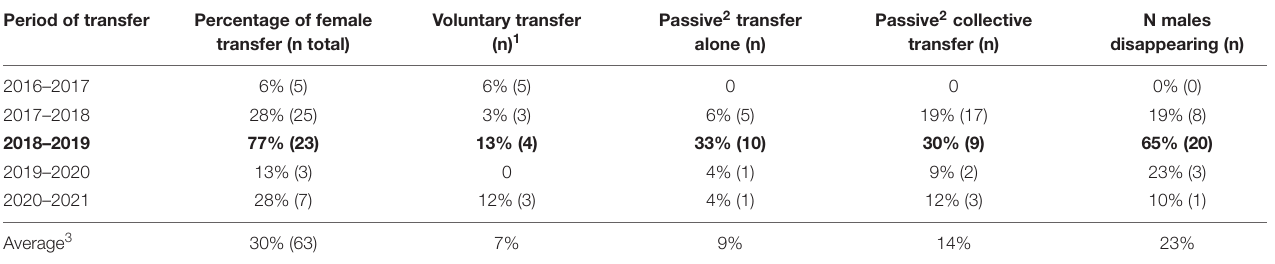
TABLE 6 | Transfer events across the observation